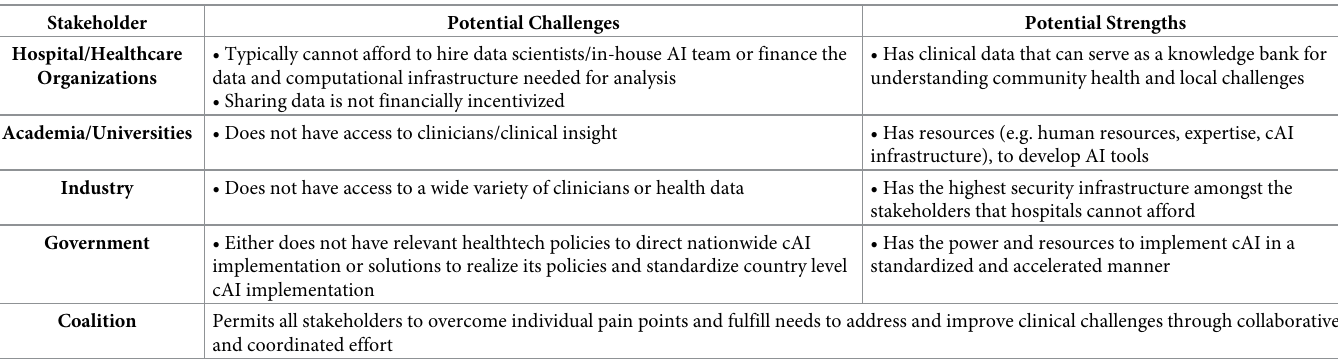
Table 2. cAI stakeholder